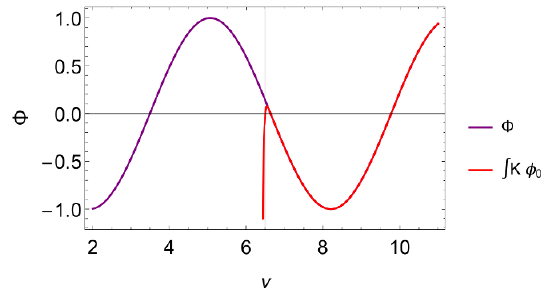
Figure 1 . We show one mode of (cid:8) as a function of (cid:23) and the expression R K(cid:30) , for d = 15. It is evident they coincide only for (cid:23) > 13 =